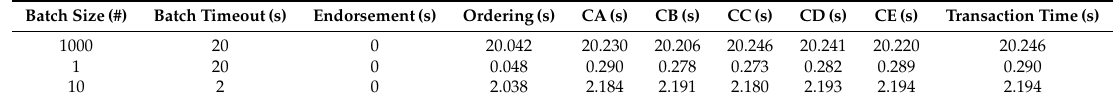
Table 5. The transaction time of a